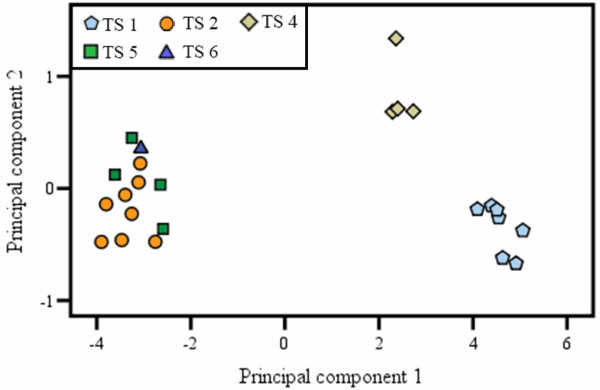
Principal component loadings of clouded leopard (Neofelis nebulosa) rear tracks. Tracks derived from left and right rear pugmarks were taken in Tabin Wildlife Reserve, Sabah, Malaysia. Different symbols indicate tracks belonging to the same track set (TS).